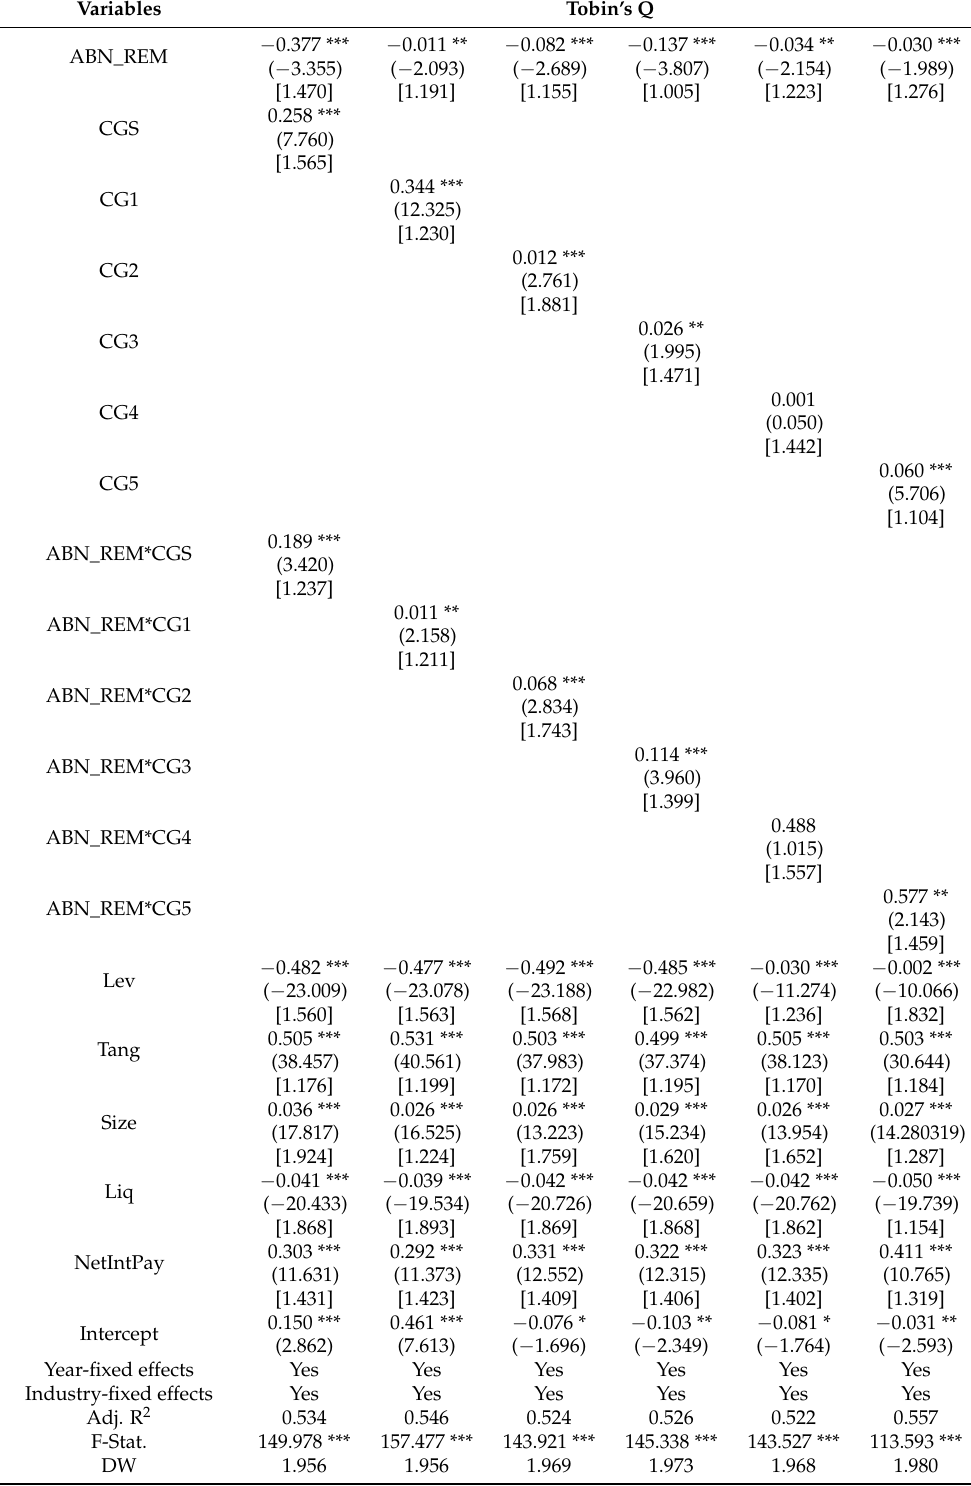
Table 5. Relationship between FV, REM, and CG with interaction effect.